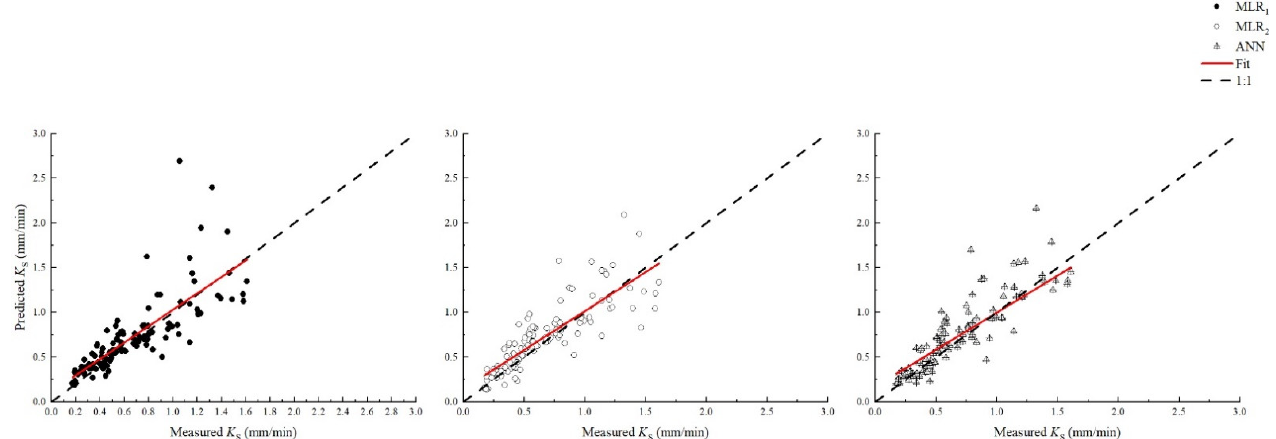
Table 6. Predictive performance of the newly established PTFs.